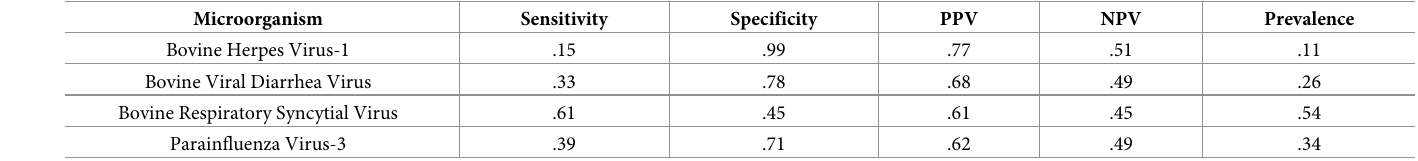
Table 8. Se, Sp, PPV, NPV, and prevalence of viral PCR from nasal swab of high-risk heifers at 1 st BRD-treatment.